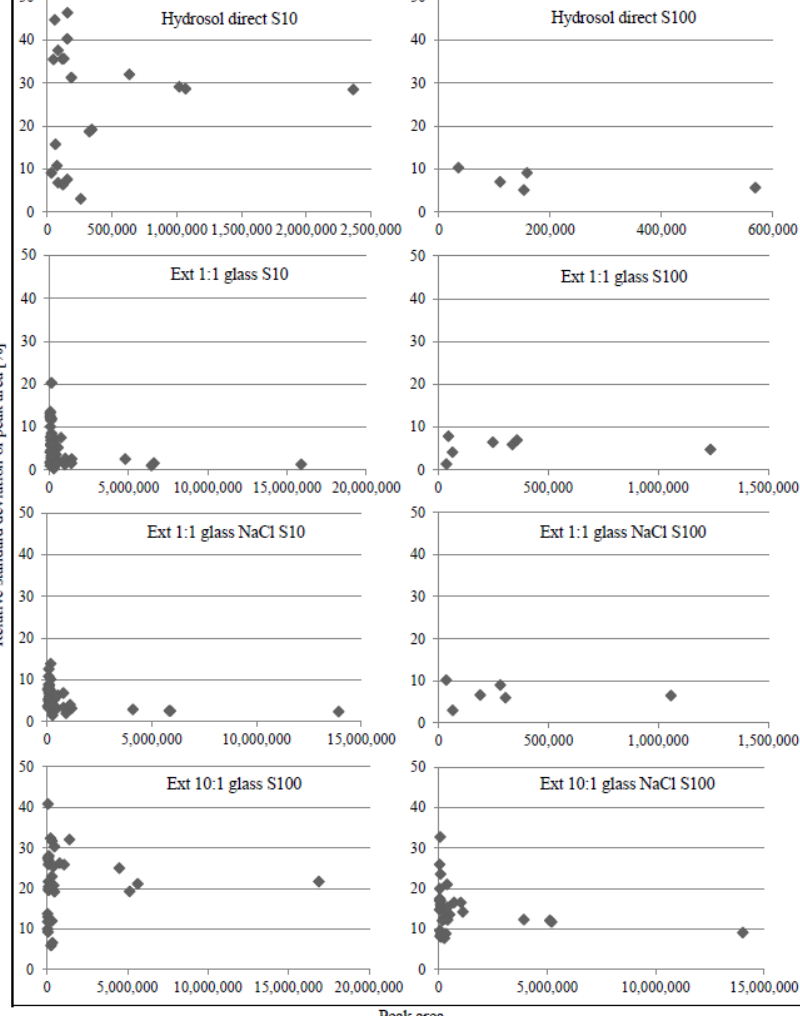
Table 1. Hydrosol compounds detected by different methods of analysis, their retention times and area % obtained. At the bottom are peak area ratios among eucalyptol, terpinen-4-ol, and alpha- terpineol.